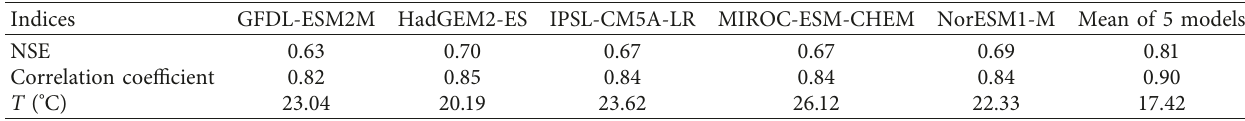
Table 7: Comparison of simulated and measured values of temperature in Guizhou from 1961 to 2000.